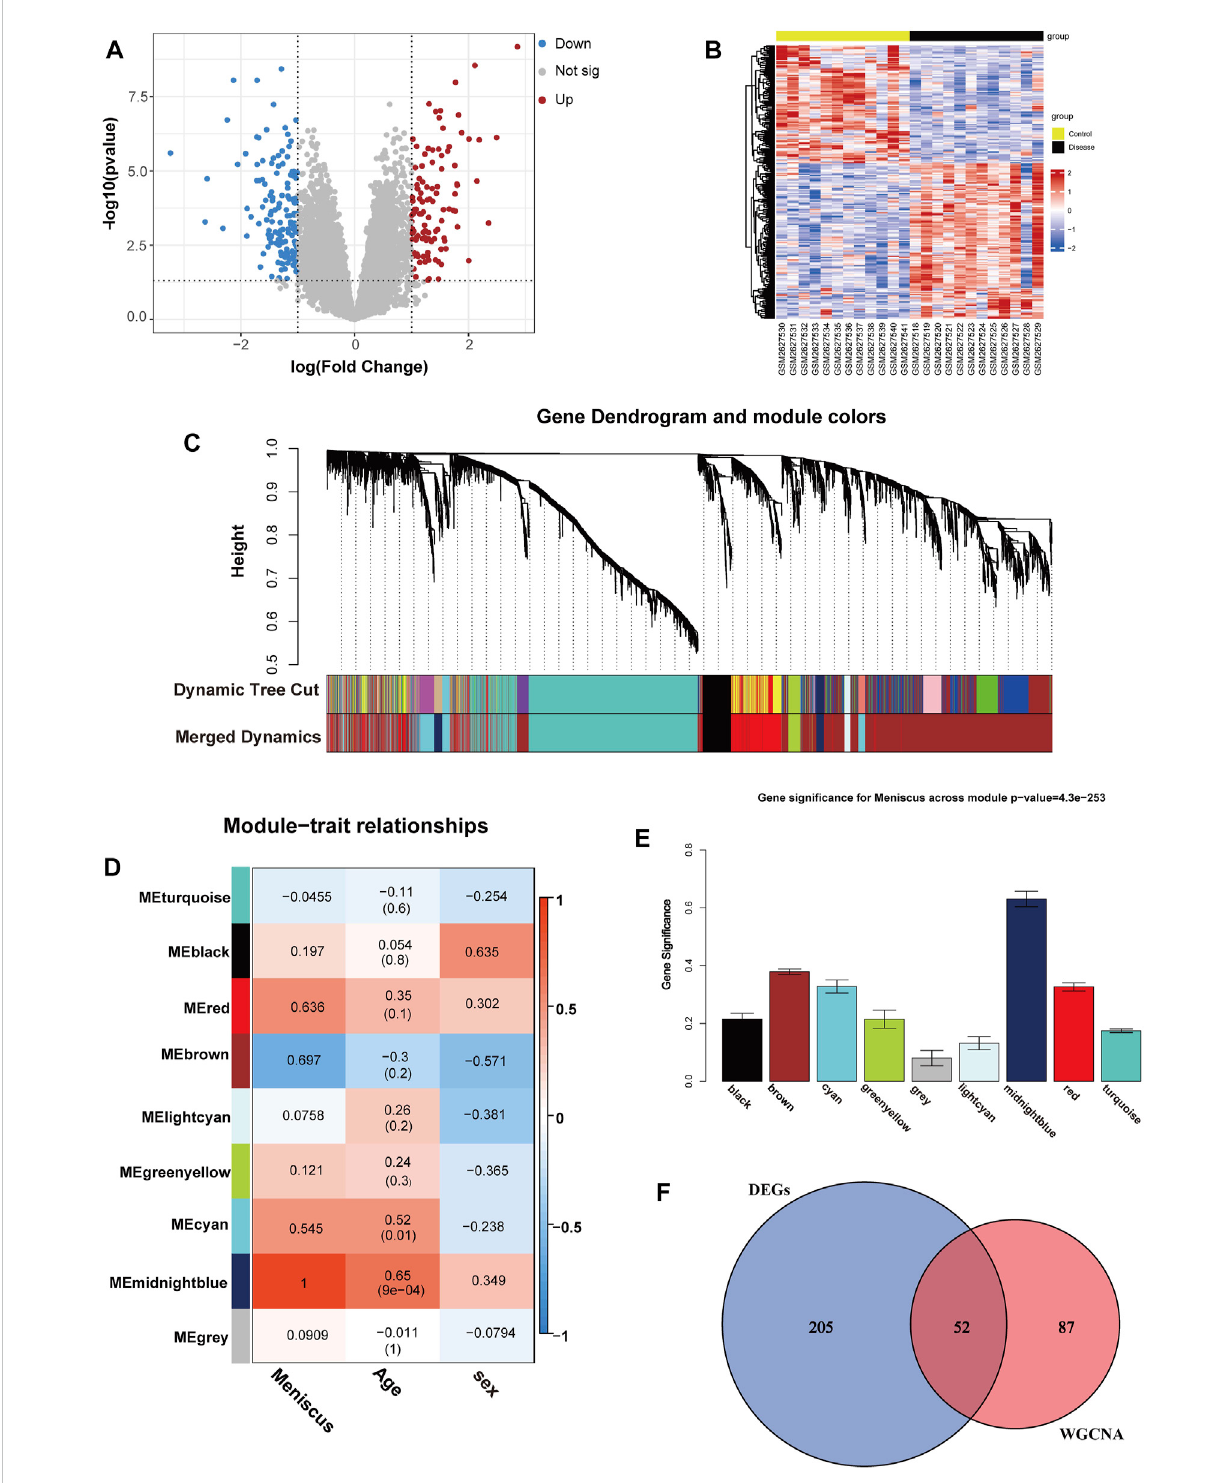
FIGURE 2 Identi fi cations of co-DEGs. (A) Volcano map of DEGs, p < 0.05 and |logFC| > 1.0 as threshold, the upregulated and downregulated genes are represented by red and blue, respectively. (B) Heatmap of DEGs. (C) The cluster dendrogram of gene modules before and after merging (D) Module and clinical traits correlation analysis. (E) Module signi fi cance values of 7 co-expression modules associated with OA meniscus. (F) Venn diagram of the key module genes and